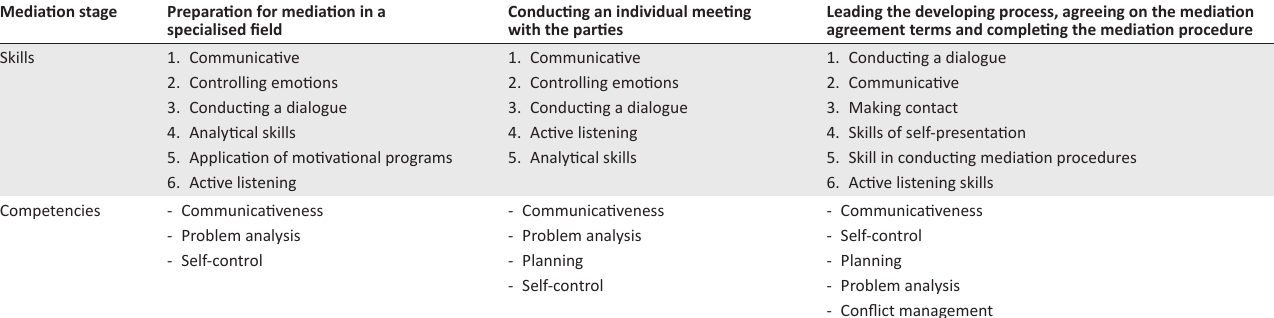
TABLE 6: Assignment of the mediation procedure stages and the necessary competence of the mediator. Mediation stage Preparation for mediation in a specialised